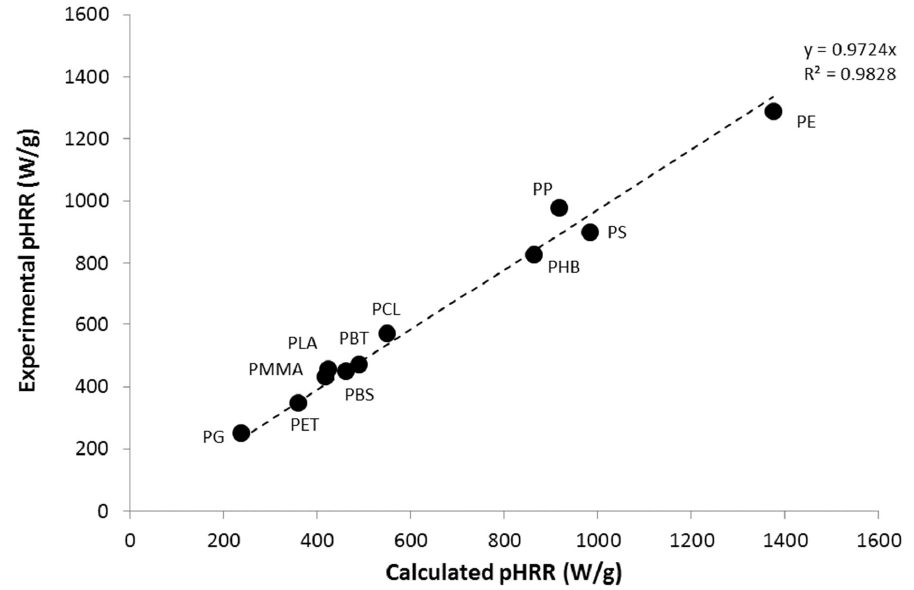
Figure 10 – Comparison between calculated and experimental pHRR for the 11 studied